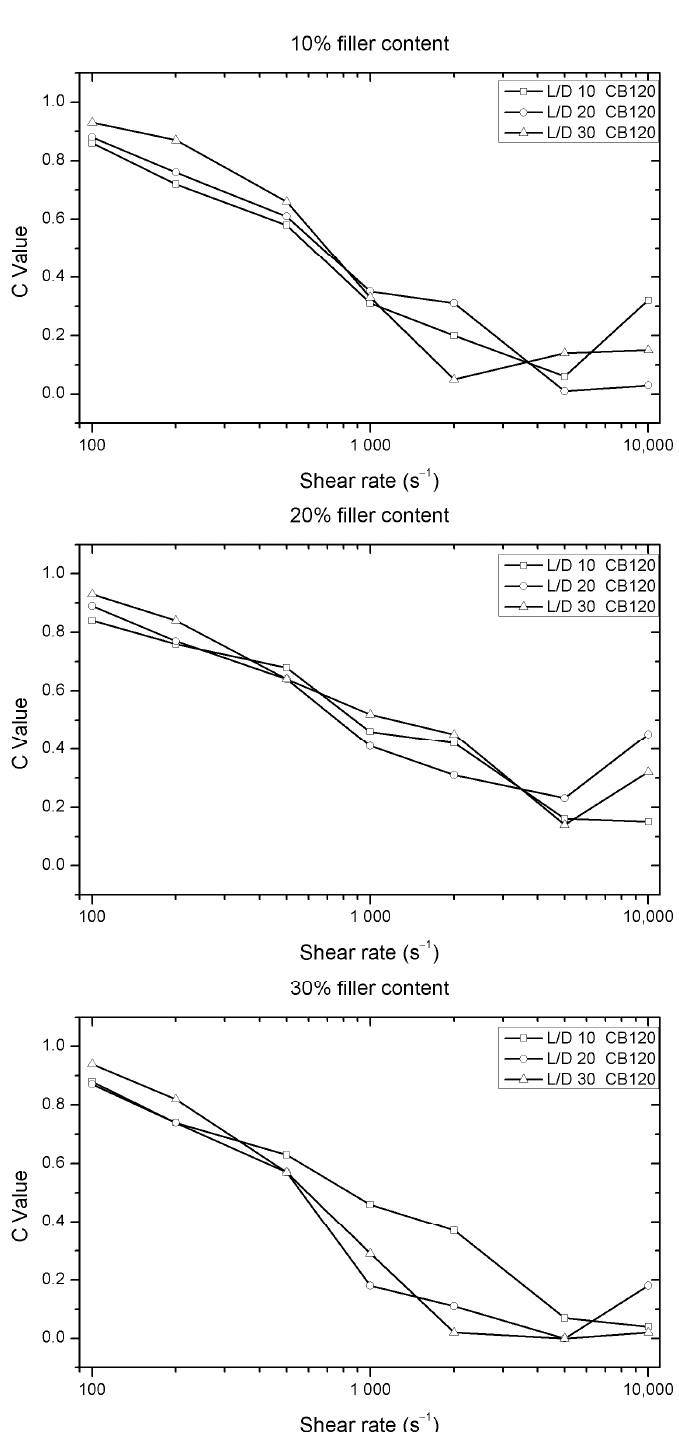
Figure 6. Evolution of C values versus shear rate for different nozzles length of the Solanyl ® with different percentages of fillers (CB 120).